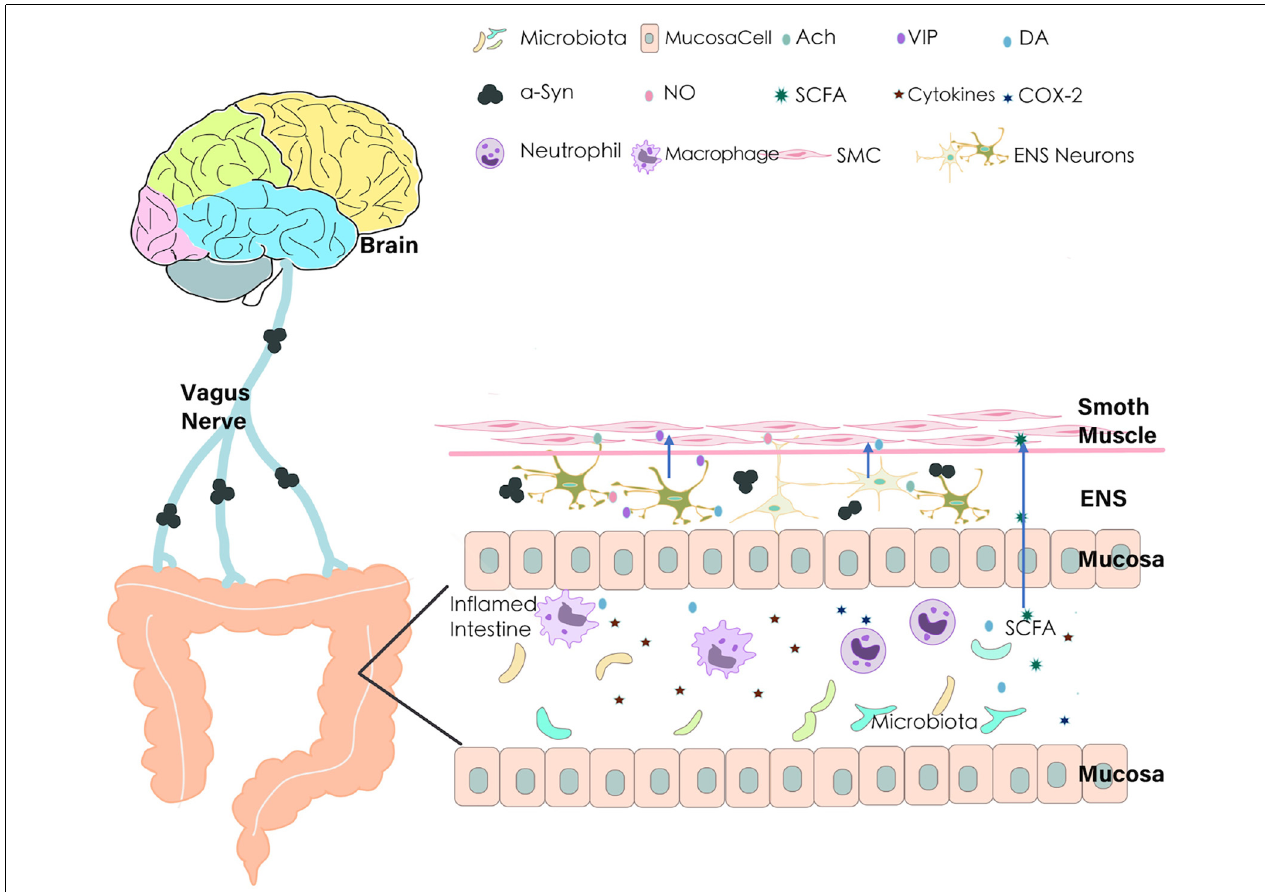
FIGURE 1 | Pathophysiology of constipation in Parkinson’s disease (PD). Many factors may contribute to the alterations of colon transport and consequently lead to constipation in PD. Aberrant aggregation of α -Synuclein leads to the vagus nerve and ENS degeneration; dysfunction of the intestinal nervous system brings out the imbalance of secretion and regulation of neurotransmitters (NO, VIP, DA, Ach); gut microbiota imbalance and product of bacterial fermentation (such SCFAs) affect intestinal dysfunction; pro-inflammatory cytokines and COX-2 in the inflamed intestine leads to decrease of The gastrointestinal (GI) transport. ENS, Enteric Nervous System; VIP, Vasoactive Intestinal Peptide; NO, Nitric Oxide; Ach, Acetylcholine; DA, Dopamine; SCFA, Short-Chain Fatty Acids; COX-2, Cyclooxygenase-2; SMC, Smooth Muscle Cell; α -Syn, α